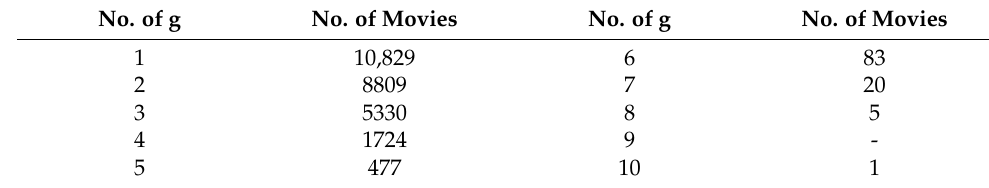
Table 6. Several g and the movies of that g in ML-20M dataset.